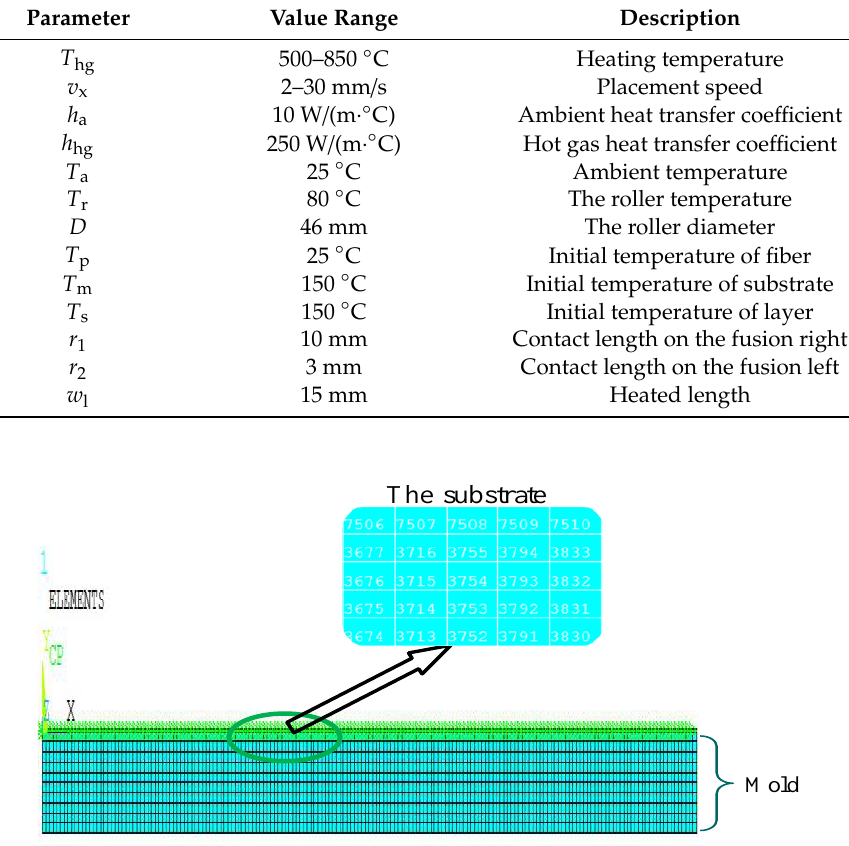
Figure 5. Finite element mesh model of layer and mold. Table 3. Parameters in boundary conditions.